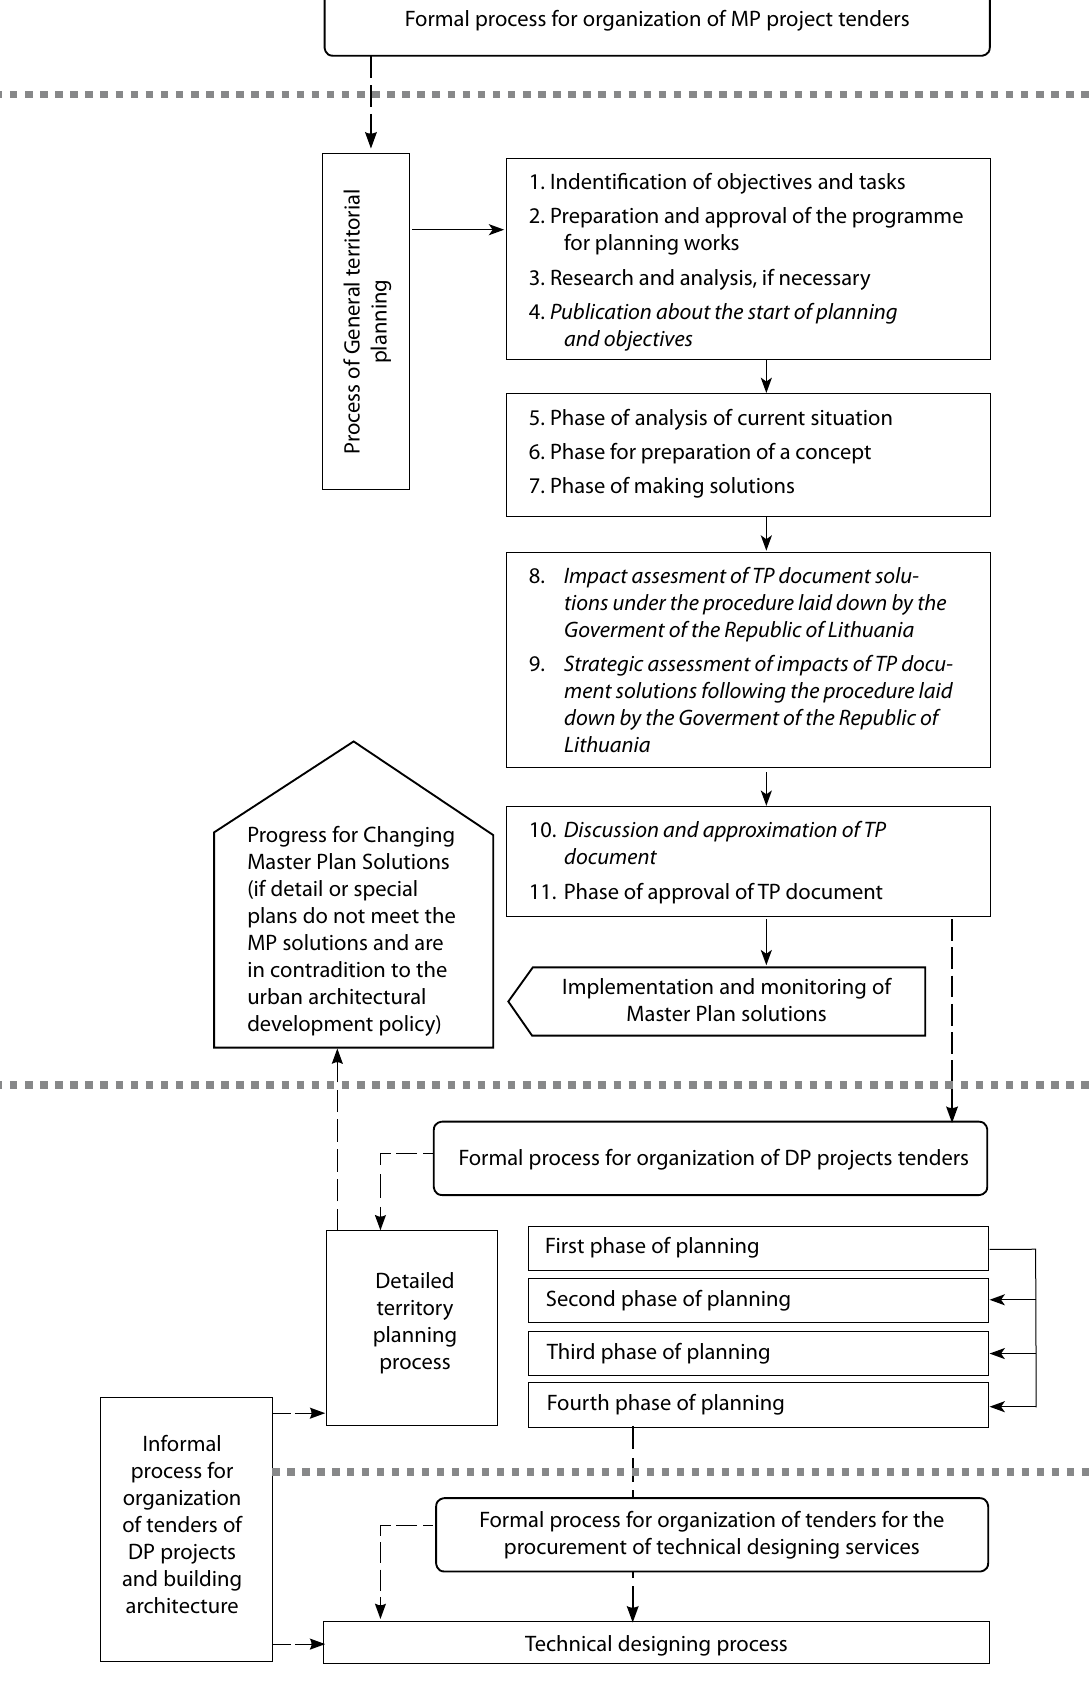
Fig. 6. Architectural activity and public procurement analysis of internecine